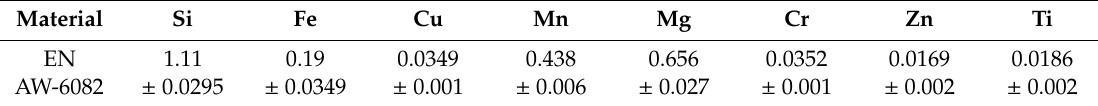
Table 2. Chemical composition of the aluminum alloy EN AW-6082 in wt.%, the balance is Al.